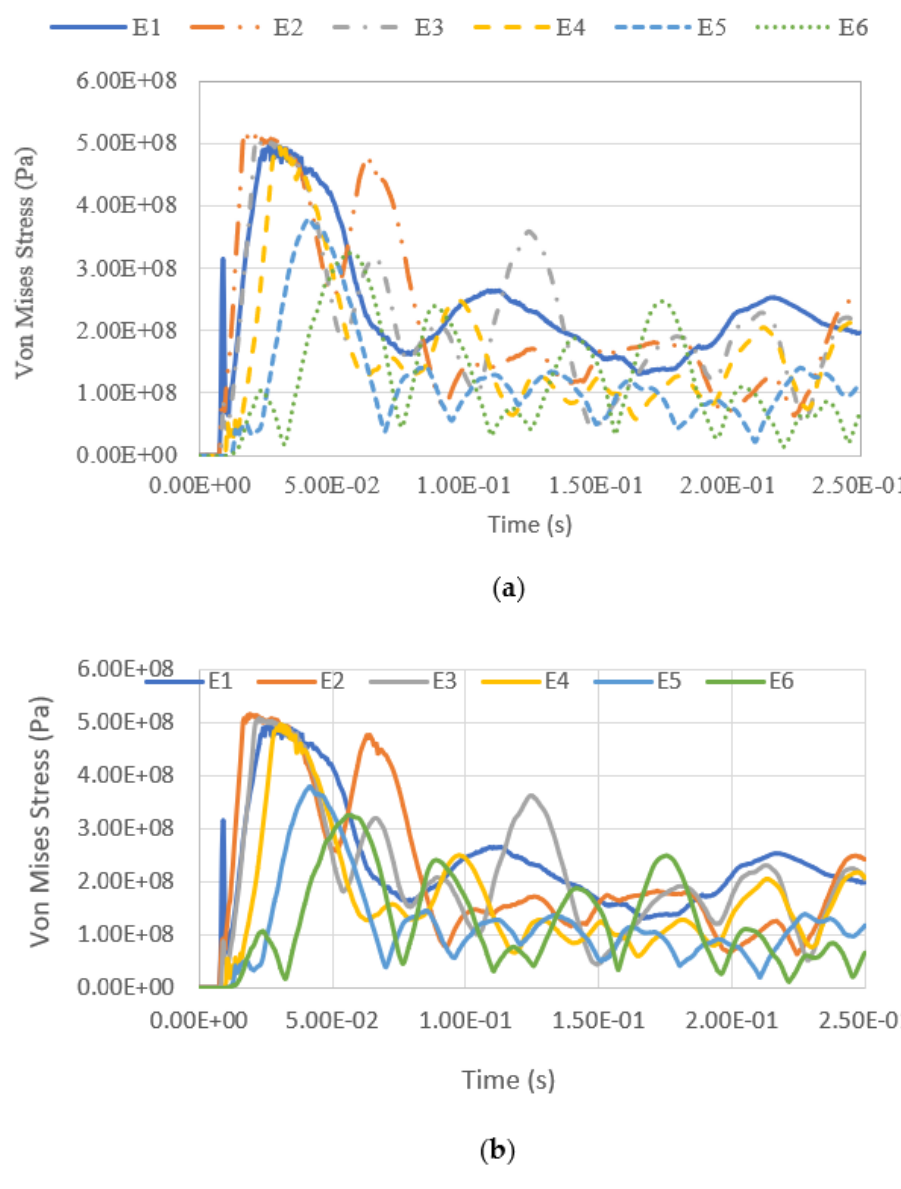
Figure 19. Equivalent stress versus time under blast intensity of 1500 kg TNT equivalent mass 12.5 m away, ( a ) 100% fill and ( b ) 0% fill .